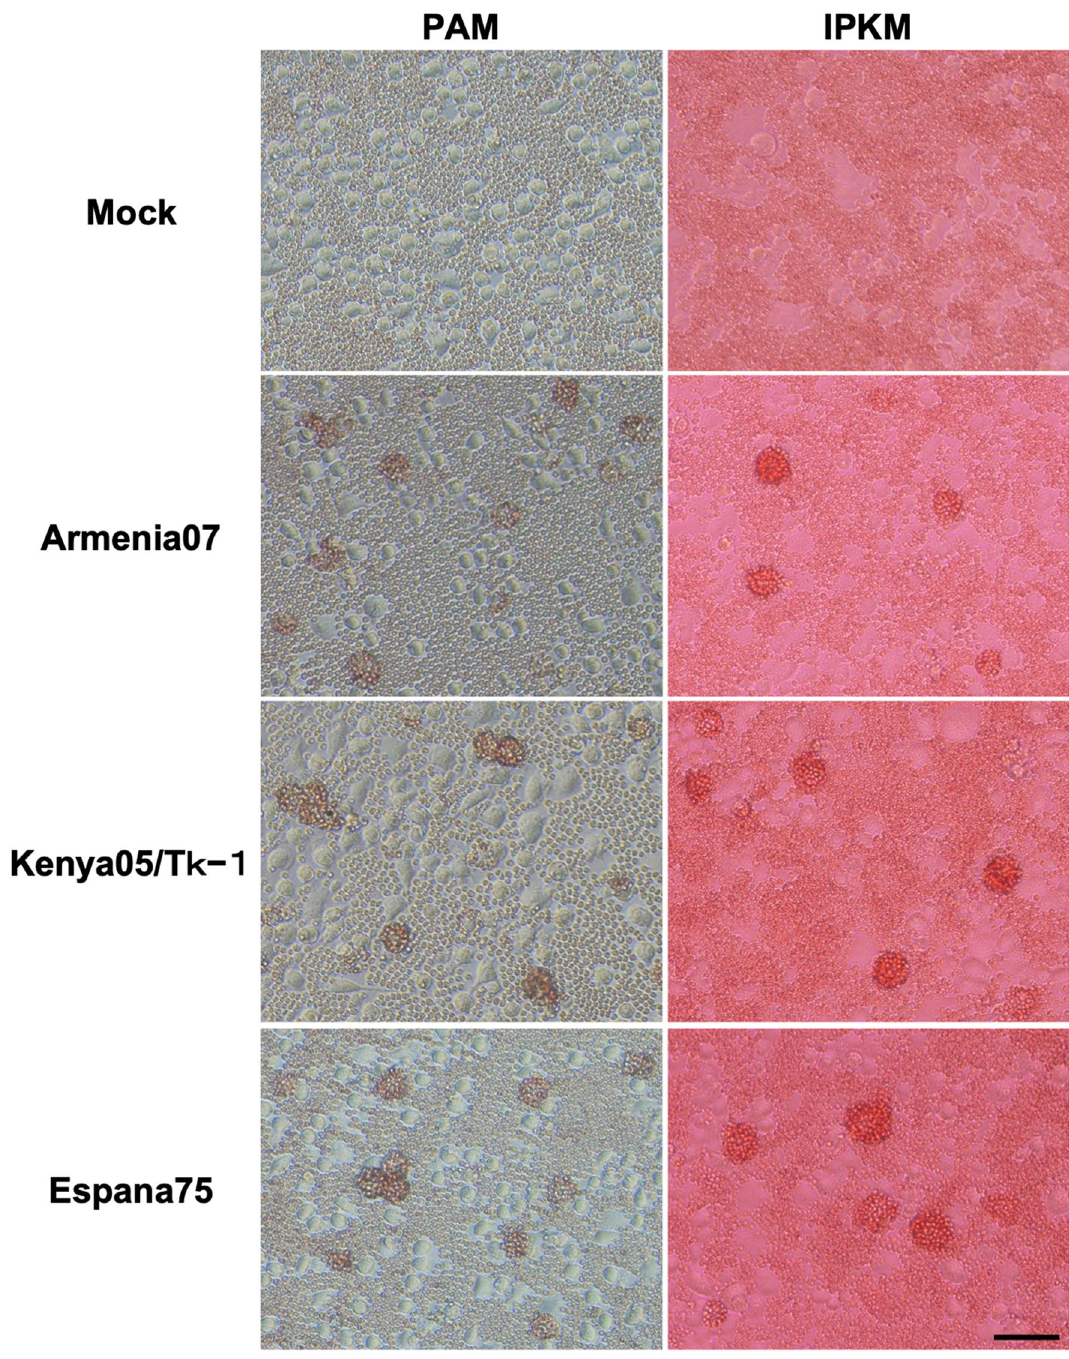
Figure 3. Hemadsorption assay in primary porcine alveolar macrophages (PAM) and immortalized porcine kidney macrophages (IPKM). Cell cultures were mock-inoculated or inoculated with Armina07, Kenya05/Tk-1 and Espana75 isolates (MOI = 0.1) in the presence of porcine red blood cells. The left and right columns show the PAM and IPKM cell cultures at 1 day after inoculation, respectively. The images are representatives from five independent experiments. Bar = 50